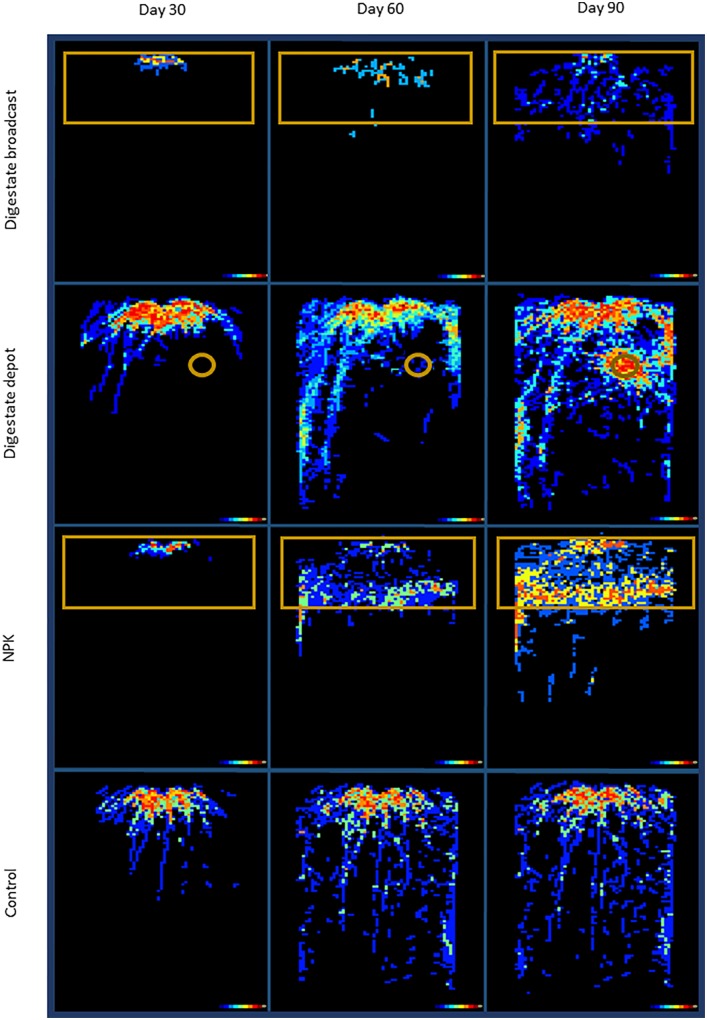
Hit-Map of rhizotrons. In digestate depot fertilized rhizotrons roots of S. hermaphrodita avoid the digestate depot zone for 60 days but form a dense root cluster in the depot zone after 90 days. Colors indicate the number of replicates that grew roots at the specific pixel (black: none; blue: 1–2; green 3–4; orange 5–6; red 7–8 replicates). Orange frames illustrate the fertilized zones of the rhizotrons. All fertilization treatments were adjusted to a digestate application of 40 t ha−1: Control: no fertilization; Digestate broadcast: homogeneously incorporated in the top 20 cm; Digestate depot: localized digestate application; NPK homogeneously incorporated in the top 20 cm; n = 8 replicates for each treatment and time of harvest.